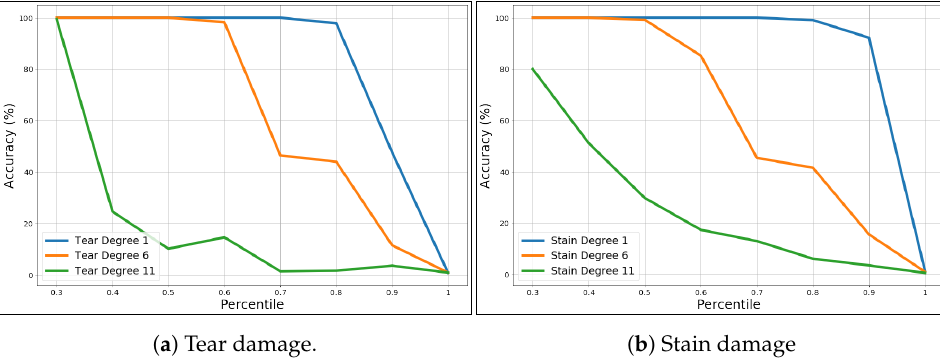
Figure 9. Accuracy variability of different percentiles on tear ( a ) and stain ( b )